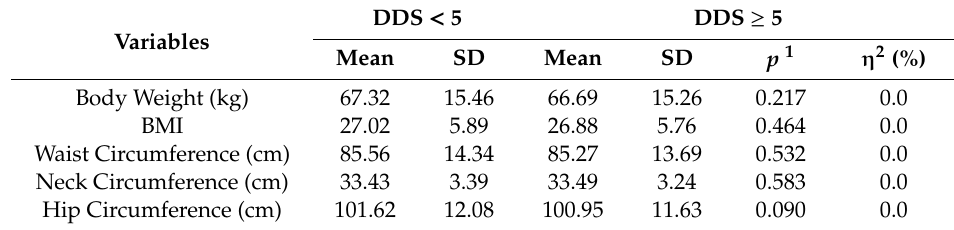
Table 4. Nutritional status and anthropometric measurements in diet diversity subgroups in